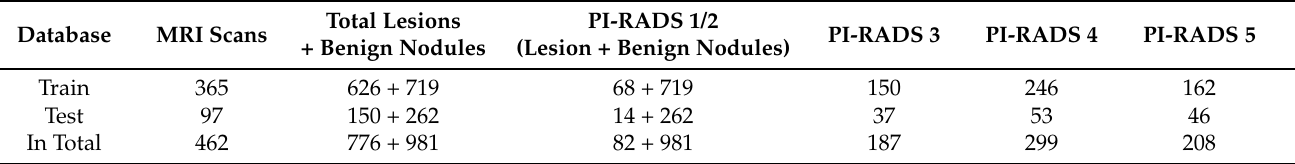
Table 2. Characteristics and data splitting of the included study samples.